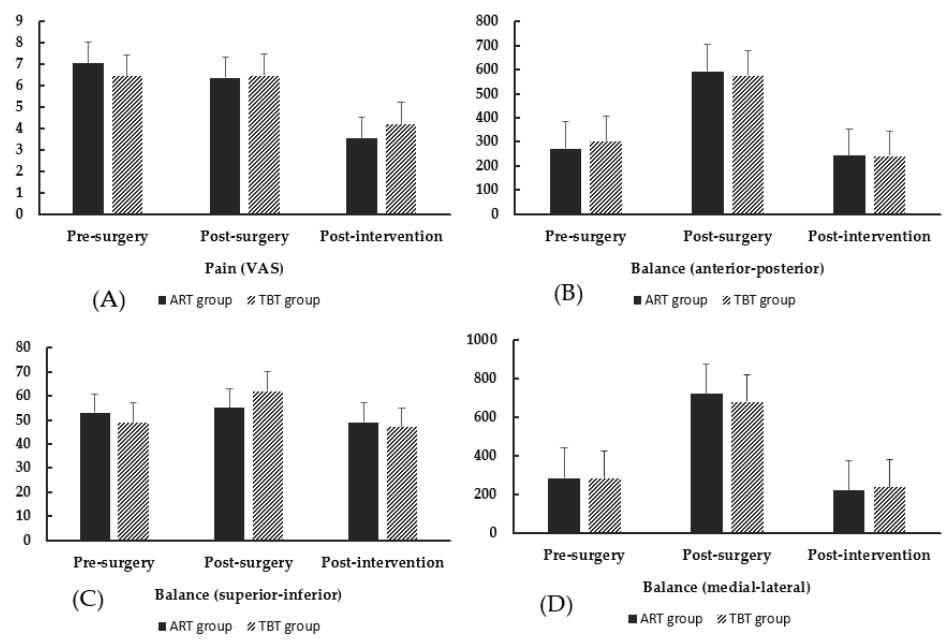
Figure 6. Comparison of pain and balance between groups. ( A ) Pain, ( B ) balance (anterior–posterior), ( C ) balance (superior–inferior), ( D ) balance (medial–lateral).